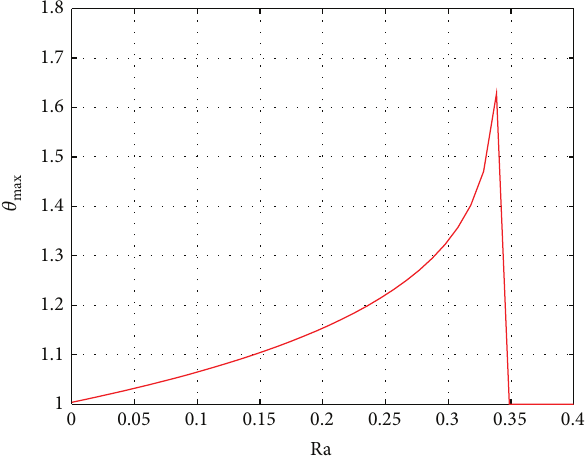
Figure 4: Blowup of fluid temperature; 𝑡 = 50